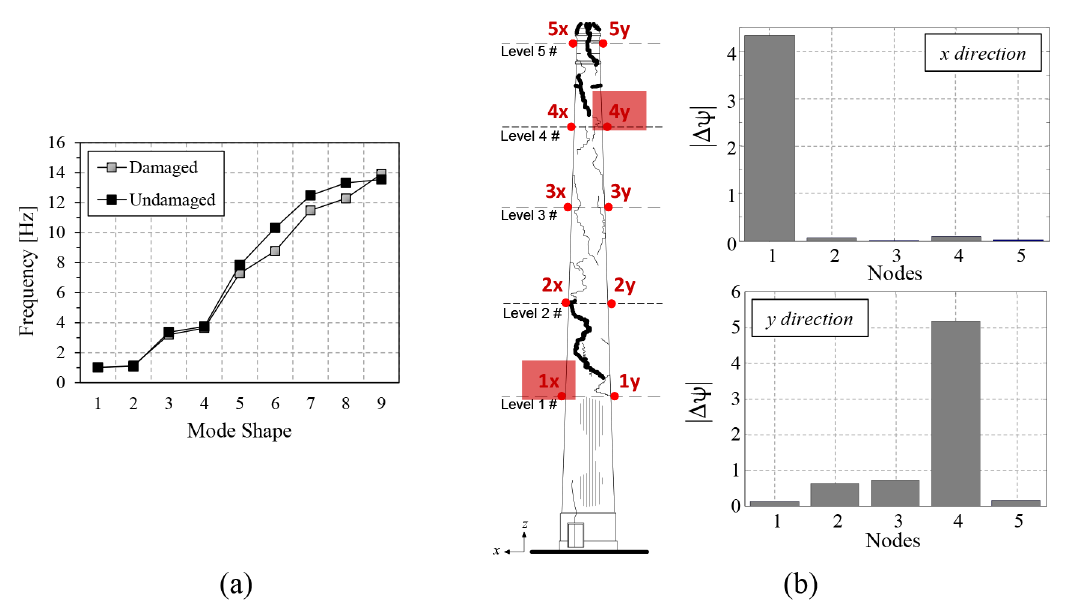
Figure 10. Results of the spectral damage analysis: (a) damage detection via the comparison of eigenvalues local maxima; (b) damage loca- lization via the spectral index (the Arabic numbers indicate the investigated DOFs and the red squares mark the damage areas pinpointed by the spectral index).